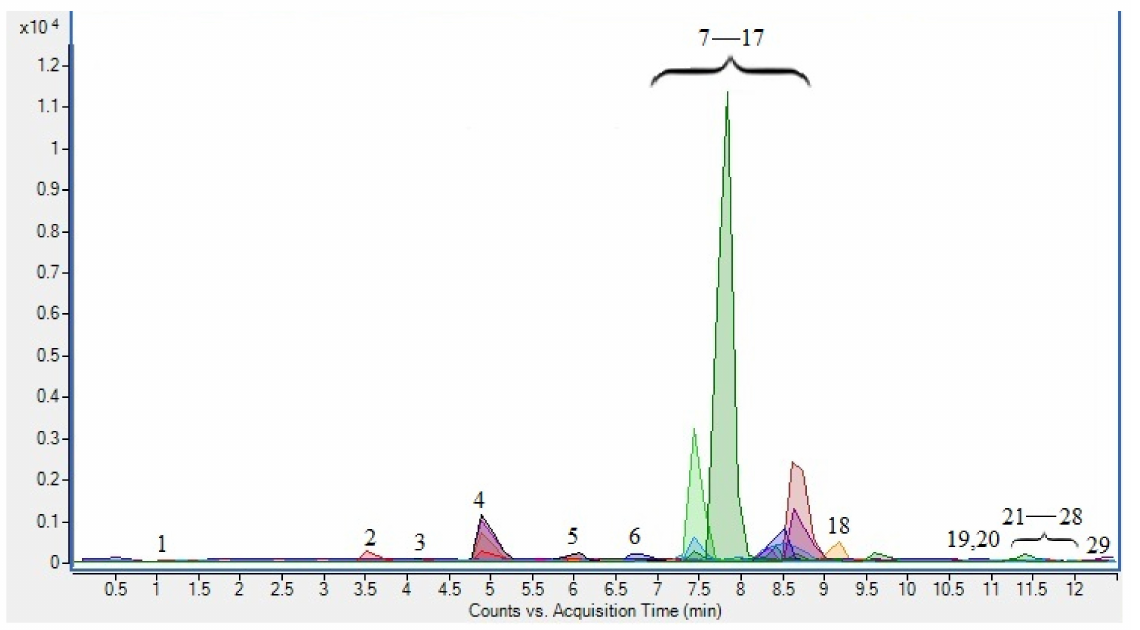
Figure 1. UPLC-MS/MS chromatogram of laurel leaf extracts obtained at optimal PLE conditions in MRM acquisition mode: (1) chlorogenic acid, (2) protocatechuic acid, (3) rosmarinic acid, (4) p - coumaric acid, (5) syringic acid, (6) luteolin-6-C-glucoside, (7) rutin, (8) ferulic acid, (9) quercetin-3- glucoside, (10) kaempferol-3-rutinoside, (11) quercetin-3-pentoside, (12) kaempferol-3- O -hexoside, (13) luteolin, (14) isorhamnetin-3-hexoside, (15) myricetin, (16) quercetin-3-rhamnoside, (17) epi- gallocatechin gallate, (18) kaempferol-3- O -pentoside, (19) caffeic acid, (20) p -hydroxybenzoic acid, (21) apigenin, (22) 3,4-dihidrobenzoic acid hexoside, (23) gallic acid, (24) catechin, (25) epicate- chin gallate, (26) procyanidin trimer, (27) apigenin-6-C-( O -deoxyhexosyl)-hexoside, (28) epicatechin, (29) kaempferol-3- O -deoxyhexoside.